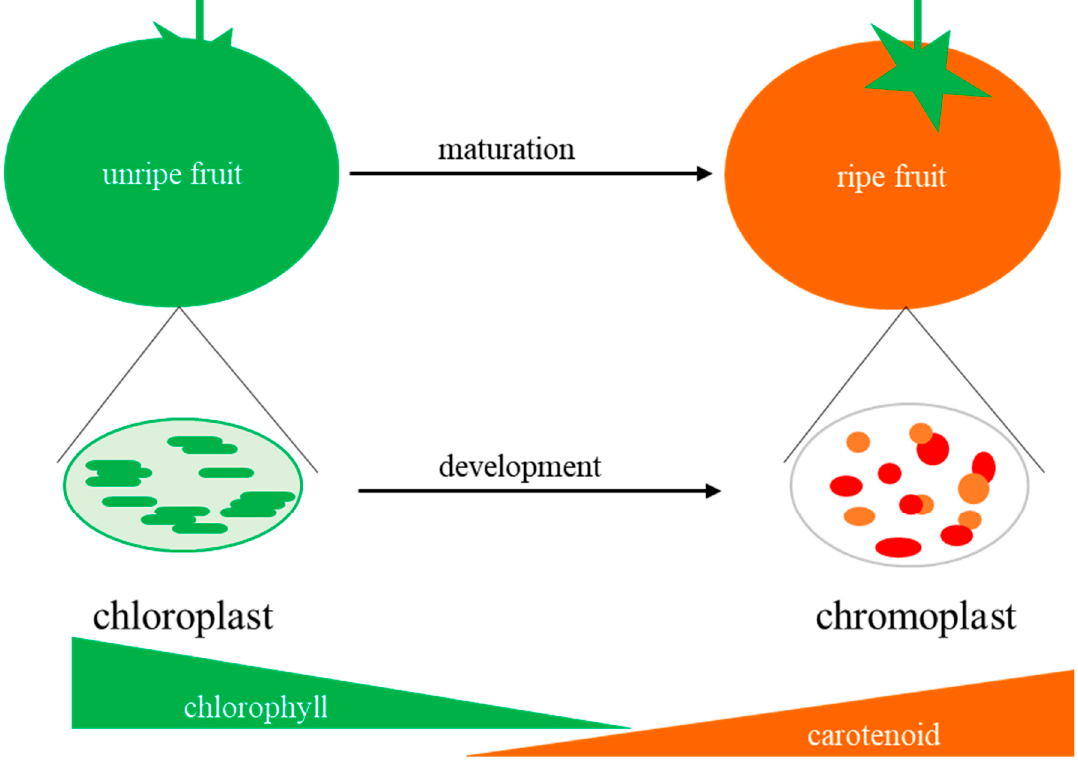
Figure 1. Chloroplast to chromoplast transition during fleshy fruit maturation. During fleshy fruit ripening, chloroplasts undergo changes to form chromoplasts, such as chlorophyll degradation and accumulation of metabolites (such as carotenoids) that contribute to nutritional quality of ripe fruit.